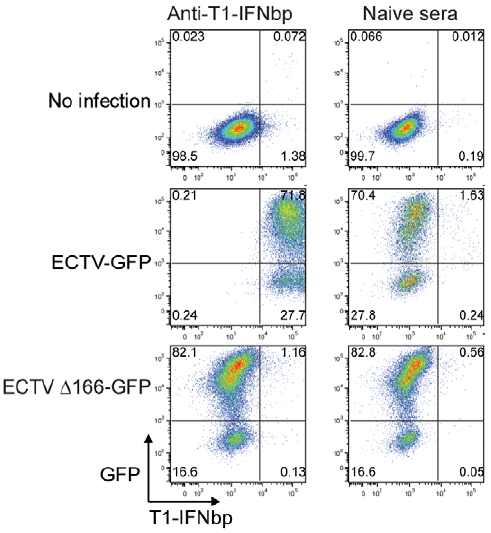
Figure 2. Secreted T1-IFNbp bind back to the cell surface of infected and uninfected cells in vitro . L929 cells were left uninfected (top panels), infected with ECTV-GFP (middle panels) or ECTV D 166-GFP (lower panels). 6 h after infection, the presence of T1- IFNbp at the cell surface was detected using anti-T1IFNbp (left panels) or naı¨ve control sera (right panel). The data are representative of two similar experiments. doi:10.1371/journal.ppat.1002475.g002 ( Figure 3C ). A similar phenomenon was also observed in the spleen, which is also a target of ECTV ( Figure S1 ). Thus, as in tissue culture, secreted T1-IFNbp binds to the surface of uninfected cells in vivo.